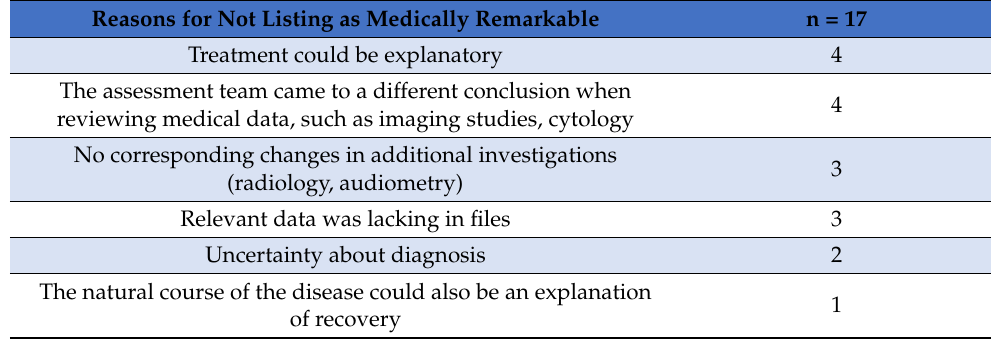
Table 7. Seventeen healings could not be evaluated as medically remarkable or unexplained by the medical assessment team, reasons are listed below.